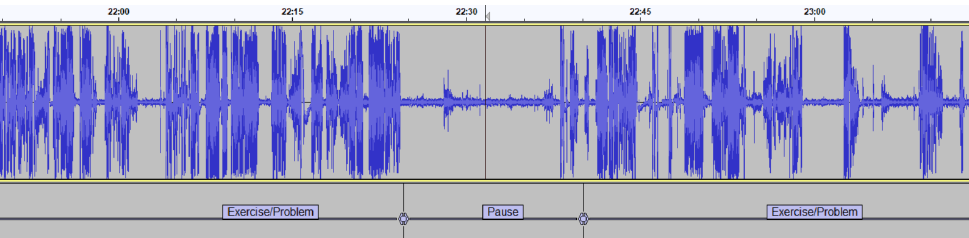
Figure 6. Audio sample of a Pause segment between Exercise segments. Table 5. Transcription of Figure